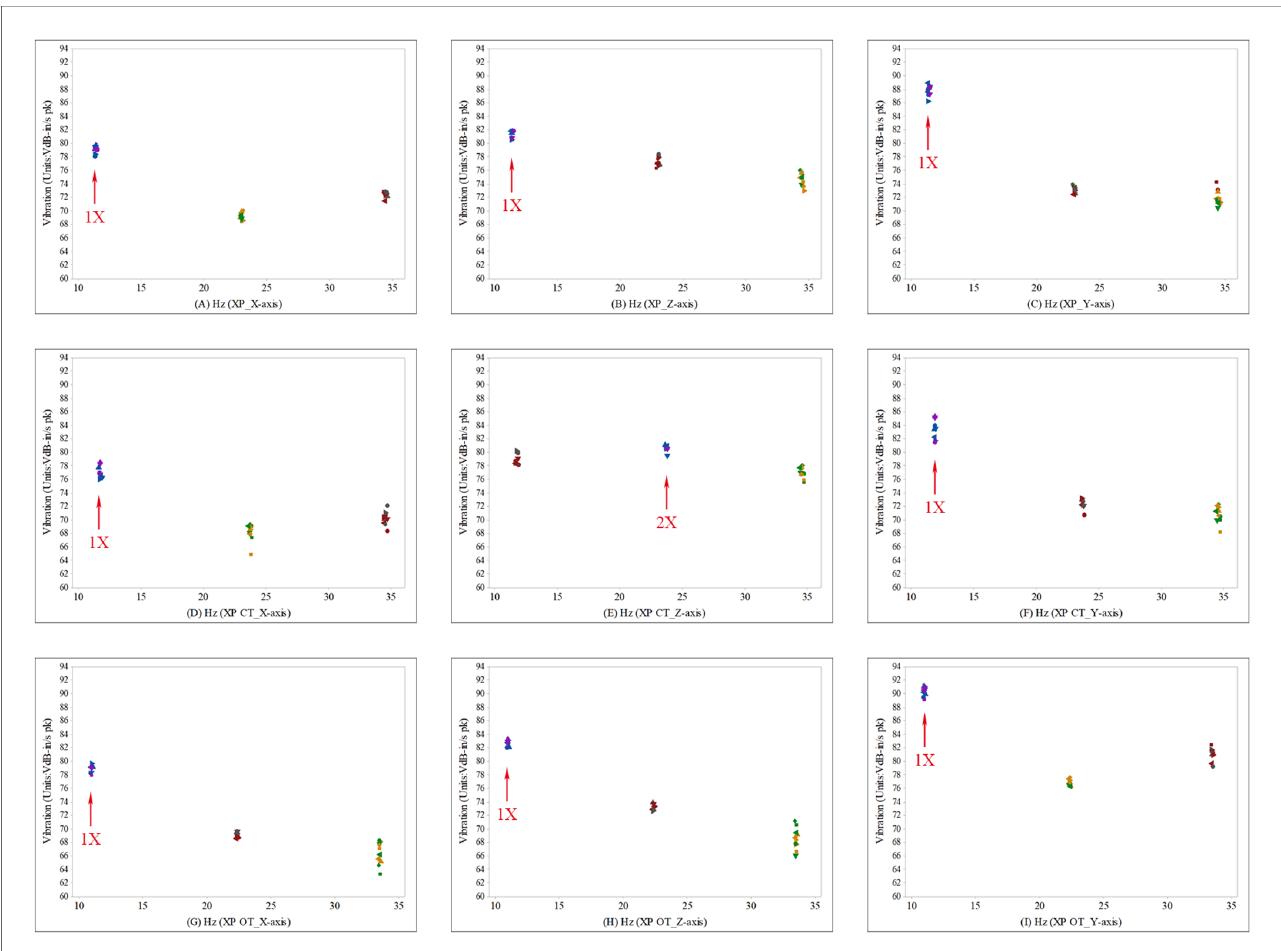
Figure 8. Scatterplot of the ignition frequency and vibration values measured in the passenger seat.